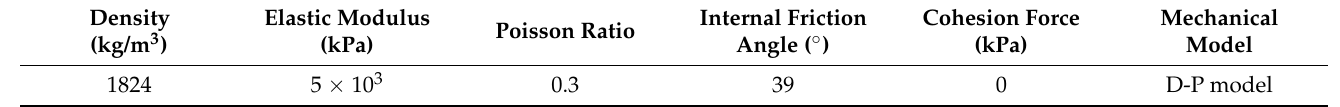
Table 4. Simulated parameters of soil.